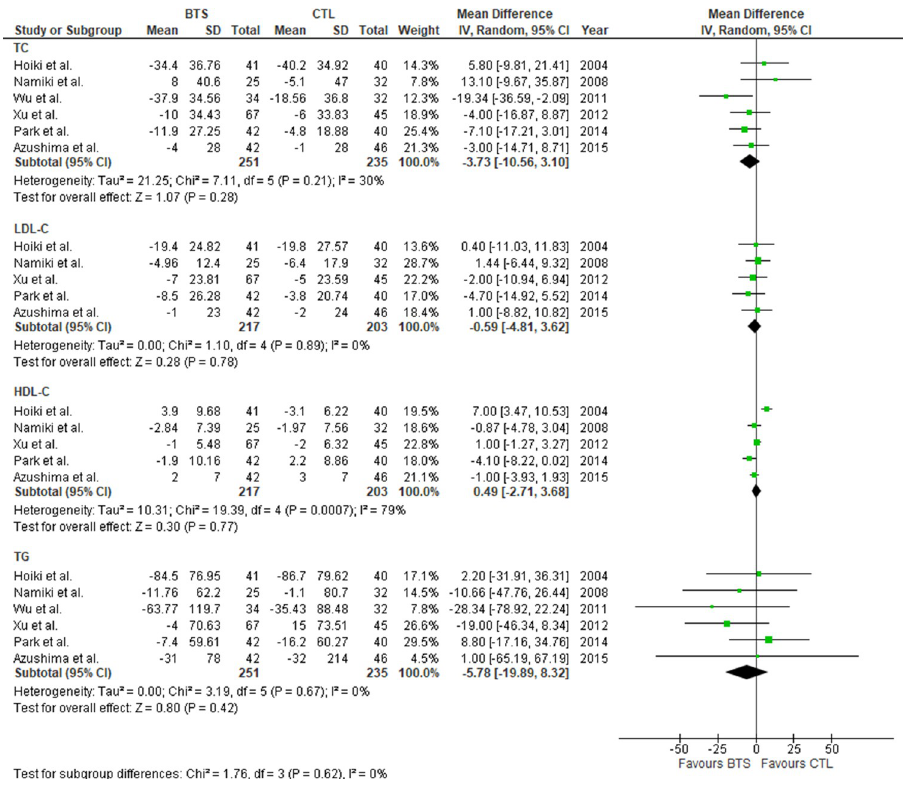
Fig 5. Meta-analysis of the effects of BTS on lipid metabolism parameters. (A) Total cholesterol. (B) Low-density lipoprotein cholesterol. (C) High-density lipoprotein cholesterol. (D) Triglyceride. BTS, bofutsushosan group; CTL, control